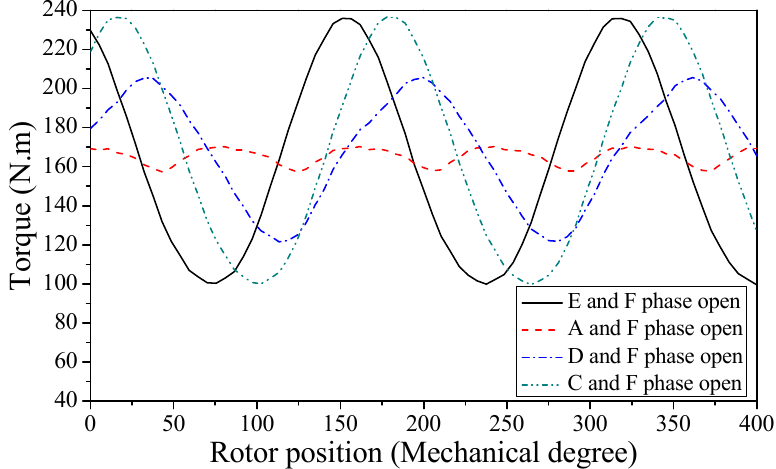
Figure 15. Torque behavior for two-phase-open fault.